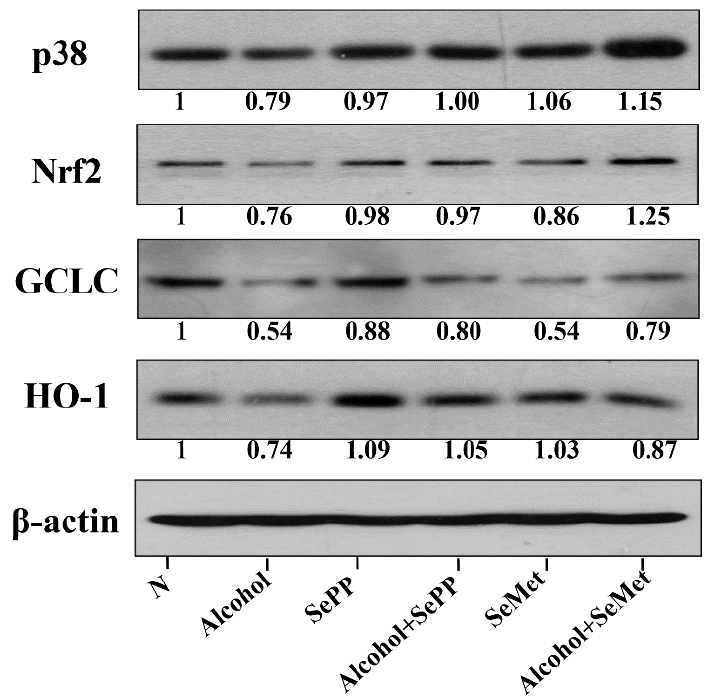
Figure 4. Western blotting of expressions of p38 , Nrf-2 , GCLC , HO-1.